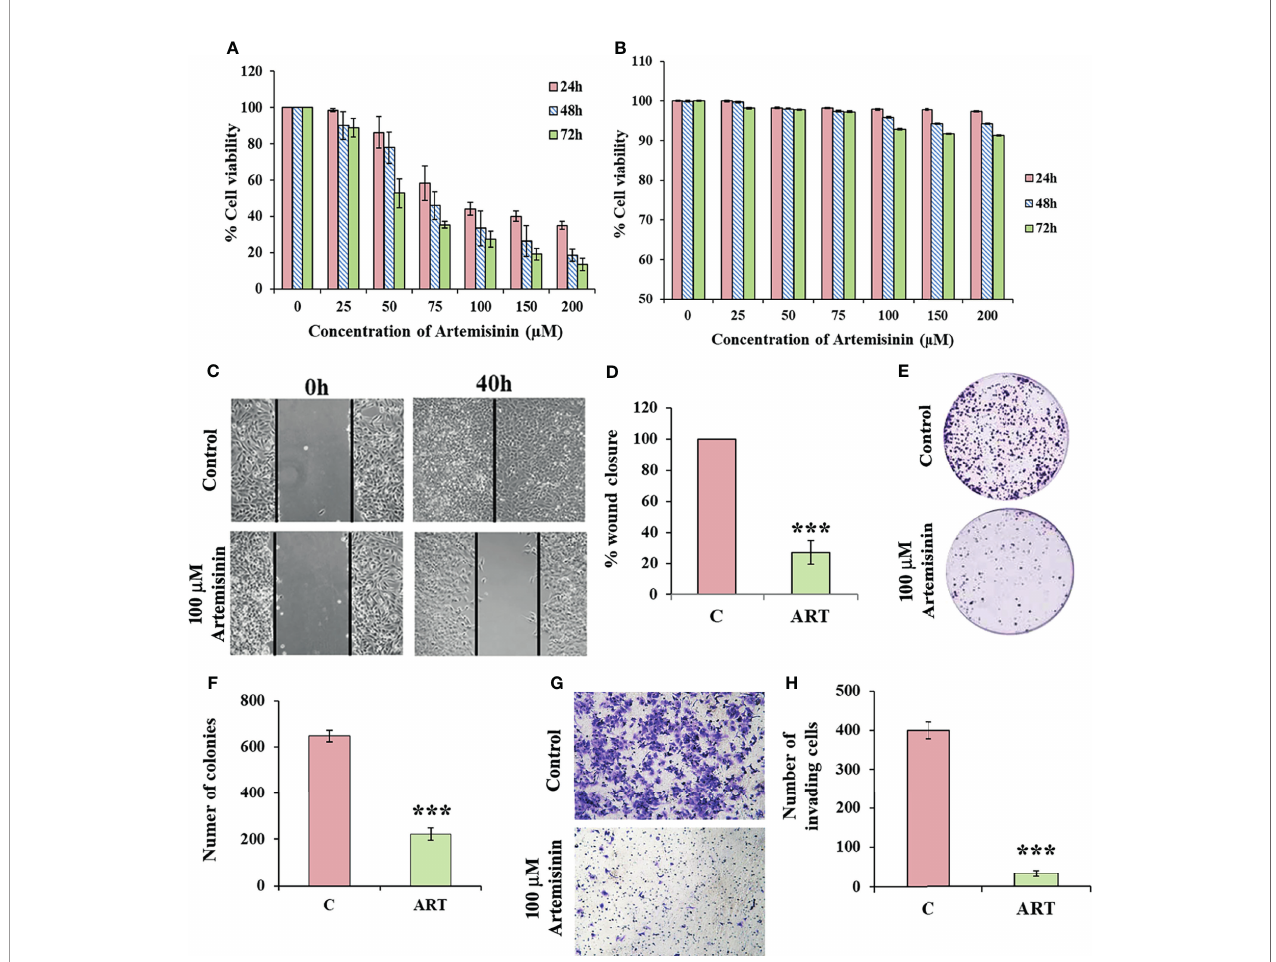
FIGURE 1 | Artemisinin mitigates HepG2 tumorigenic potential. (A) The percent cell viability from MTT assay of HepG2 cells treated with increasing concentrations of Artemisinin (25, 50, 75, 100, 150 and 200 µM) for 24, 48 and 72 h or vehicle is graphically presented. (B) Percent cell viability of HEK293T cells exposed to varying concentrations of Artemisinin or vehicle followed by assessment using MTT assay is shown. (C) Scratch assay was performed in cells exposed to 100 µM Artemisinin for 40 h. Representative images of the scratched area at the indicated time-points are presented (D) Percent wound closure is graphically shown. (E) Colony formation assay was executed in cells exposed to 100 µM Artemisinin for 48 h. Representative images of stained colonies are shown. (F) The measured number of colonies is graphically represented. (G) Matrigel invasion assay was performed in cells following exposure to 100 µM Artemisinin for 48 h. Representative images of stained cells are provided. (H) Graph showing the number of invasive cells. *** p < 0.001. All data are expressed as the means ± standard deviations of three independent experiments. The two-tailed Student ’ s t -test was used to determine whether the differences between vehicle-treated set and Artemisinin-treated set were signi fi